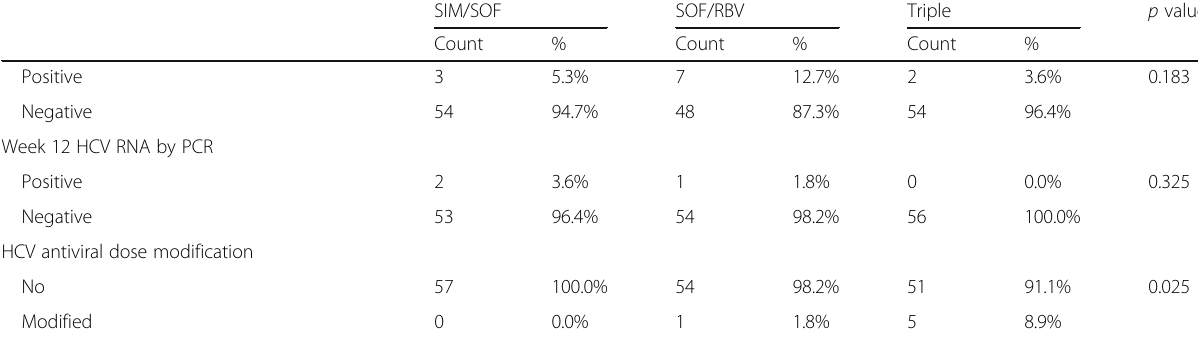
Table 1 Non parametric parameters of the three groups on anti-HCV treatment (Continued)